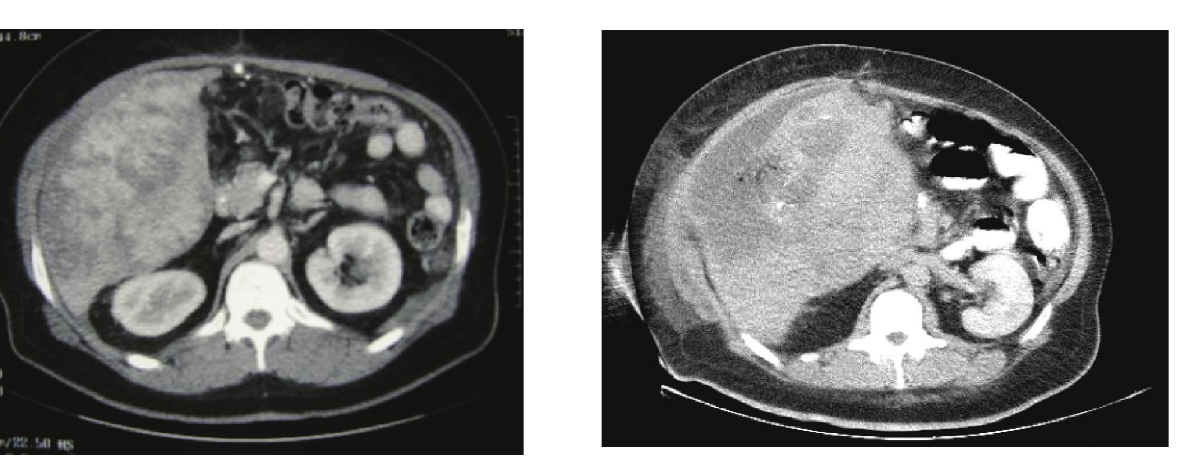
Figure 3: CT scan abdomen with contrast demonstrated highly vascular tumor with heterogeneous uptake pattern consistent with hepatic angiosarcoma.